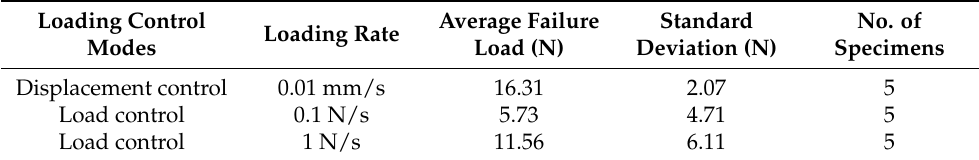
Table 1. Summary of the test results of the 1 × 8 PLC optical splitter